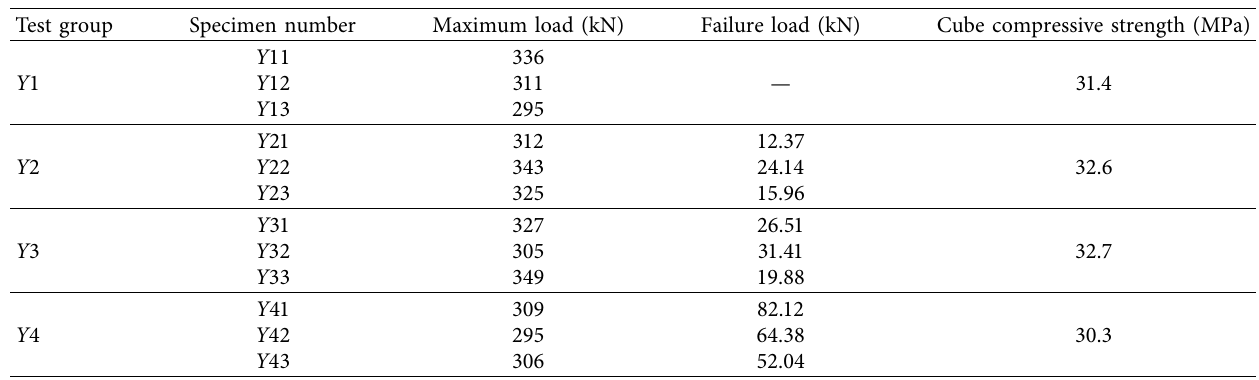
Table 4: Compressive strength of the